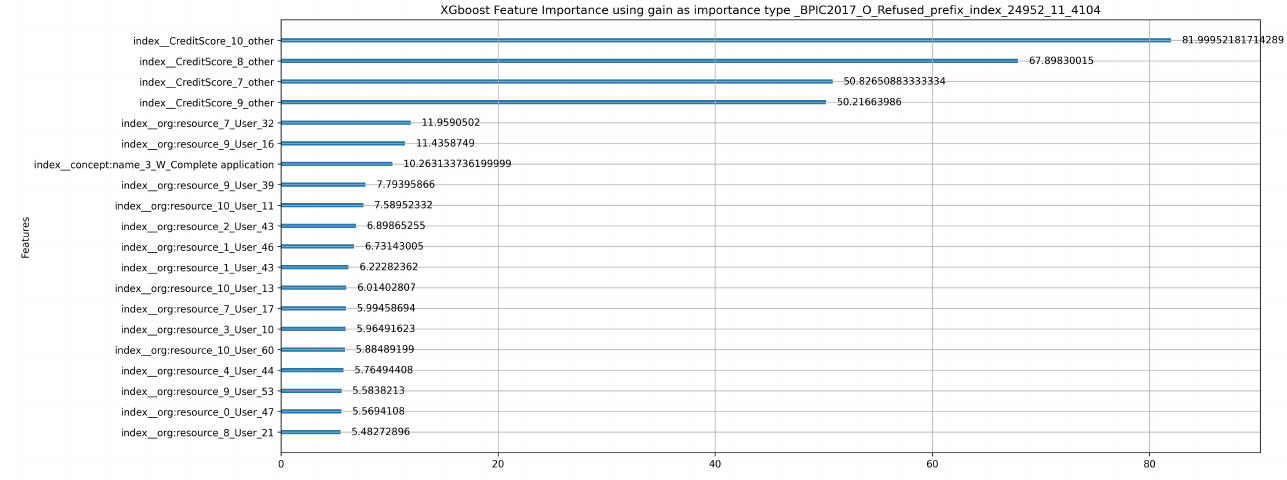
Figure 7. LR coefficients for different prefix lengths of BPIC2017_Refused .